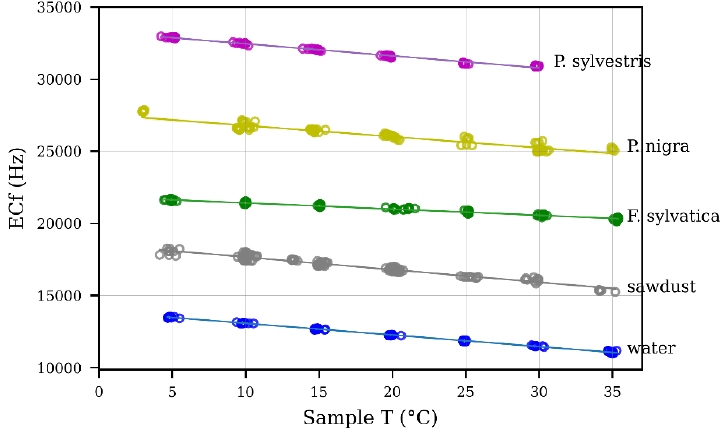
Figure 8. Temperature sensitivity analysis for the capacitance sensor used in the Ref probe TT+ across different substrates. Table 2. Temperature sensitivity analysis for TreeTalker’s Ref probe exposed to different substrates. Coefficients ‘ m 1 ’ and ‘ b 1 ’ are presented for a linear equation in the standard form of ECf T = m 1 ∗ T + b 1